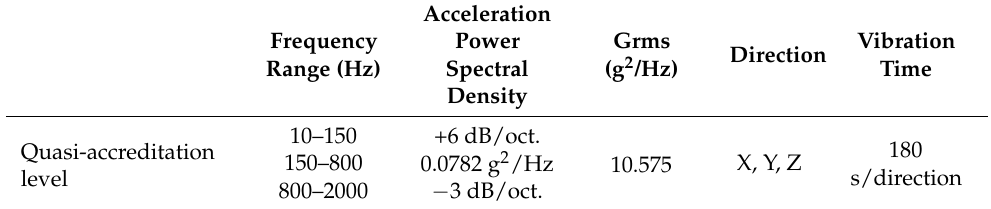
Table 4. Random vibration test